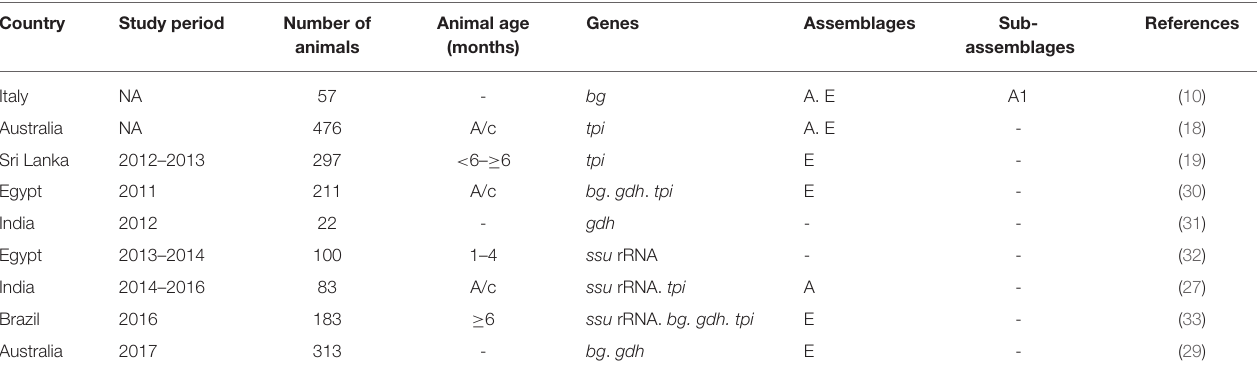
TABLE 4 | Assemblages and sub-assemblages of G. duodenalis in buffaloes worldwide.